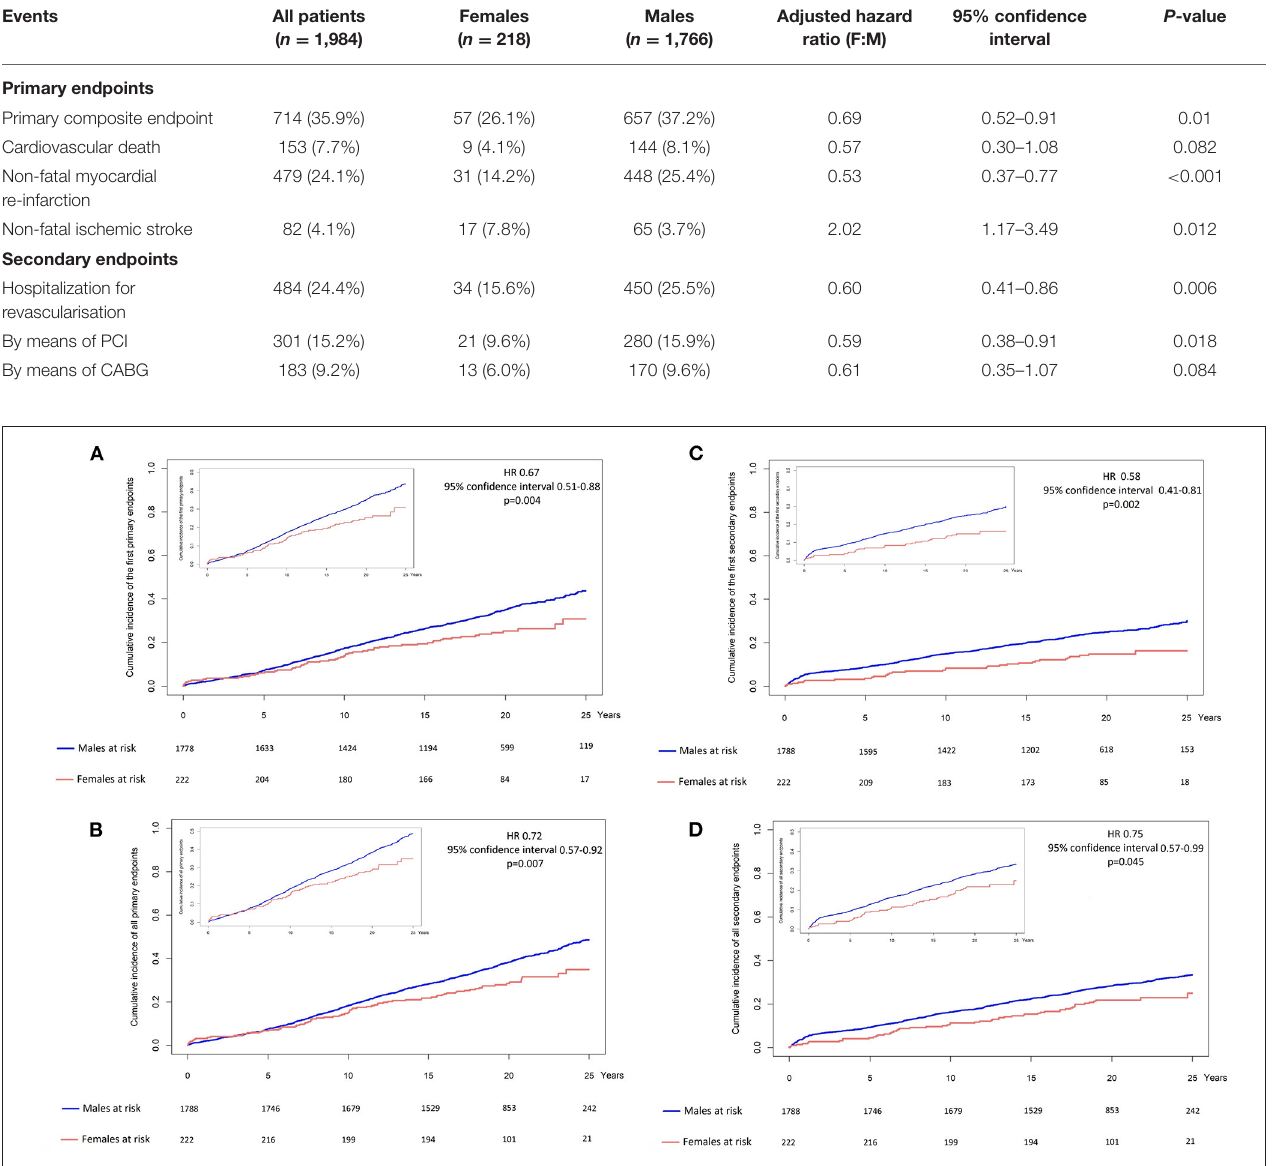
FIGURE 1 | (A) Cumulative incidence of the first primary endpoint by sex. (B) Cumulative incidence of the first secondary endpoint by sex. (C) Cumulative incidence of all primary endpoints by sex. (D) Cumulative incidence of all secondary endpoints by